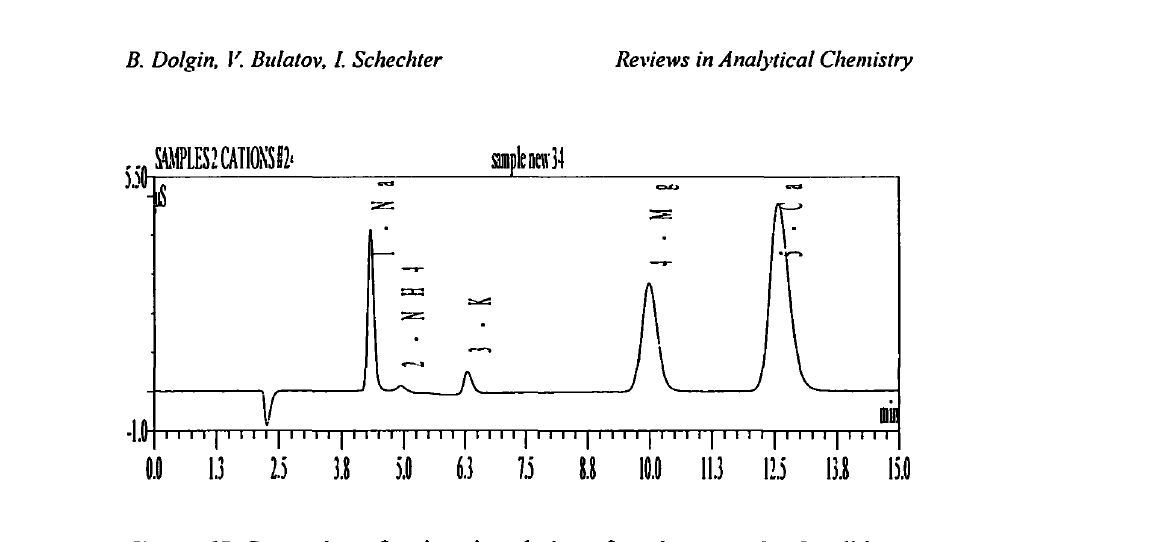
Figure 65. Separation of cations in solution of modern sample. Conditions: column, Dionex® lonPac® CS12A; eluent, 18mM methanesulfonic acid; flow rate, l.OmL/min; detection, suppressed conductivity with a cation self-regenerating suppressor (CSRS) operated at 75mA in self-regenerating mode; injection volume, 25 μι; solutes, 1) sodium, 2) ammonia), 3)potassium, 4) magnesium, 5) calcium.